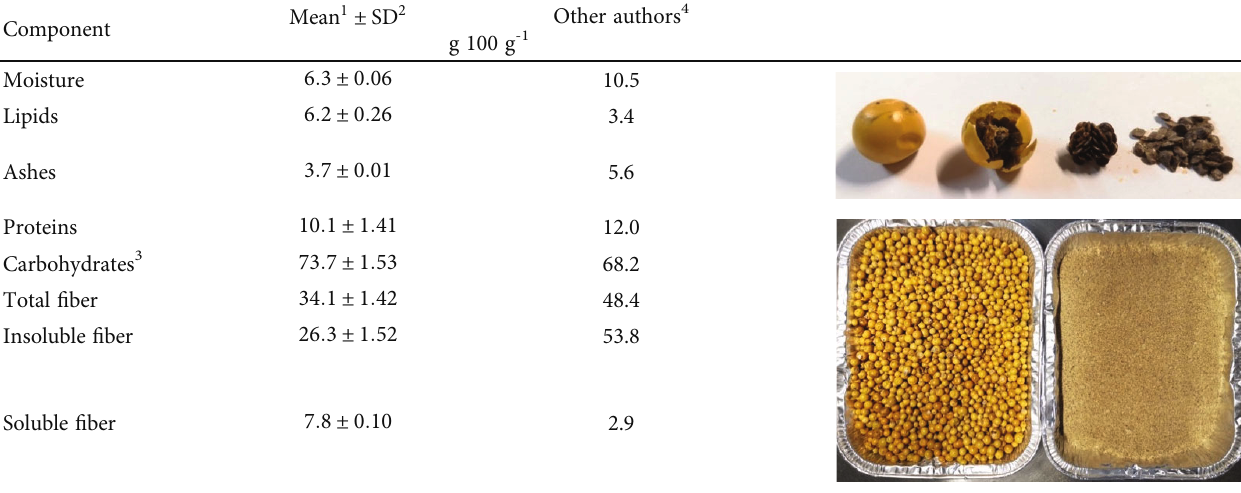
Table 1: Compositional analysis of the powder obtained from yellow and dry fruits of Solanum elaeagnifolium plants.